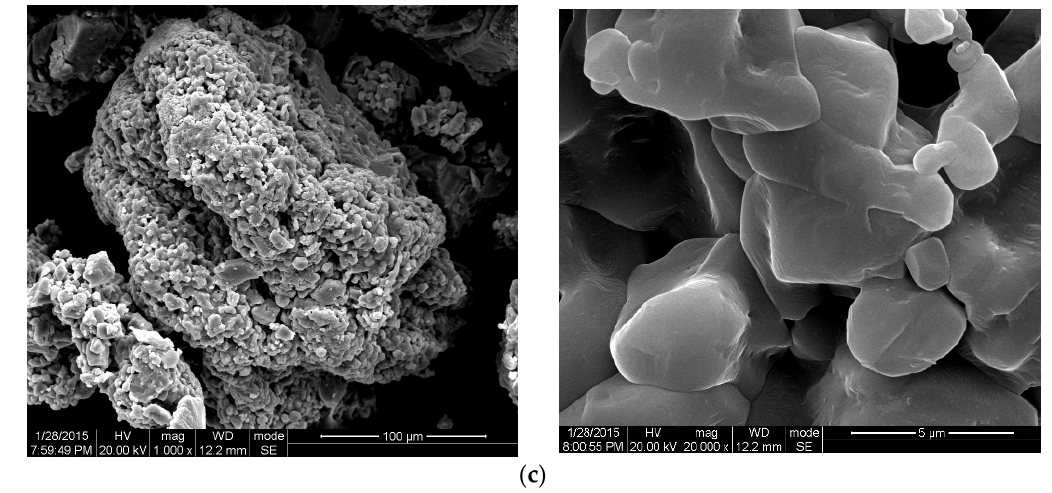
Figure 6. SEM results of SFPDF containing the GC treatment agent. ( a ) SEM results of the KL polymer drilling fluid; ( b ) SEM results of the PAM polymer drilling fluid; and ( c ) SEM results of the XC polymer drilling fluid.